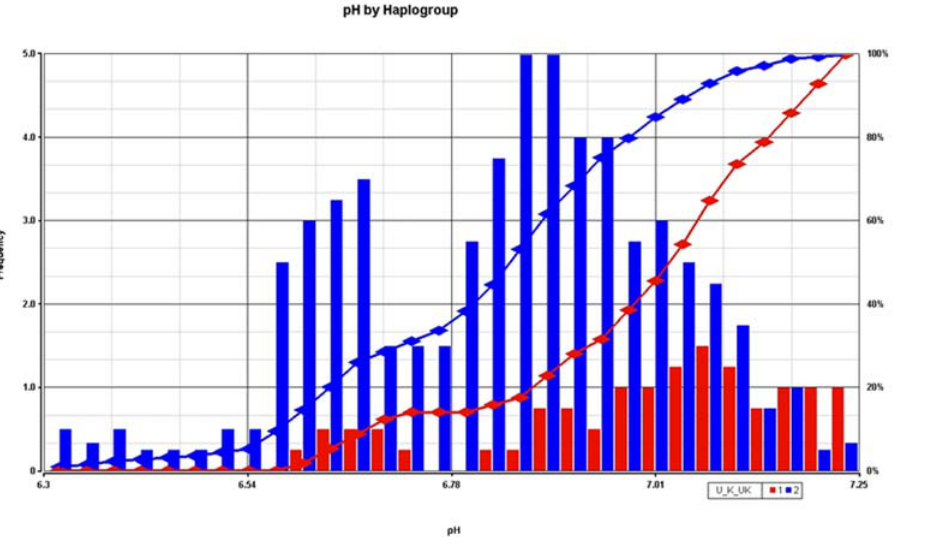
Figure 4. The super haplogroup (U, K, UK) showed a shift in postmortem brain pH, and this finding was significant following permutation analysis. The histogram shows the frequency of the pH (bars) for the super haplogroup (red) compared to all other matrilineages (blue). The accumulated percentage (right y-axis) is shown as two lines with the super haplogroup (red line) and all other matrilineages (blue line). There were no subjects with a prolonged death, or agonal factors as rated according to the Hardy et al. scale [98]. PMI differences did not account for this significant effect, as PMI was equivalent between the super haplogroup and other haplogroups. doi:10.1371/journal.pone.0004913.g004 PLoS ONE |